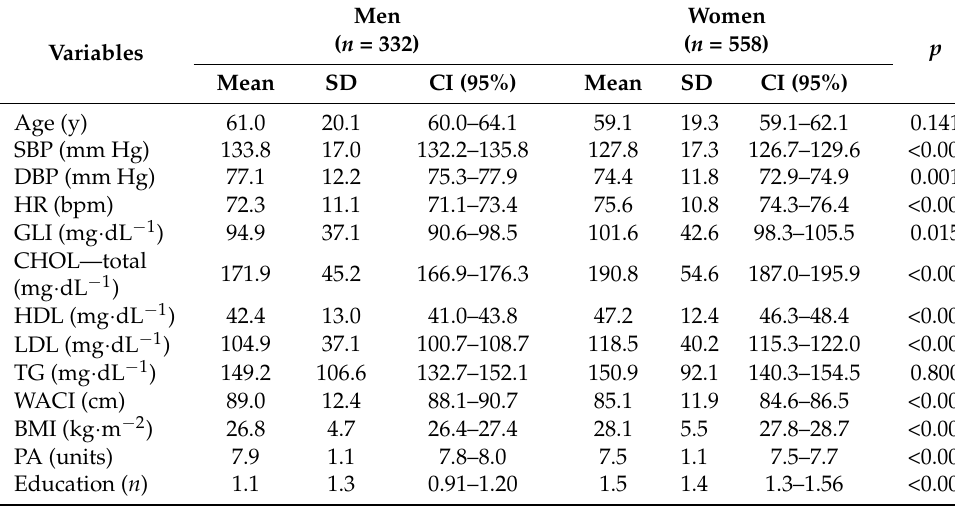
Table 1. Descriptive characteristics of the sample by sex.